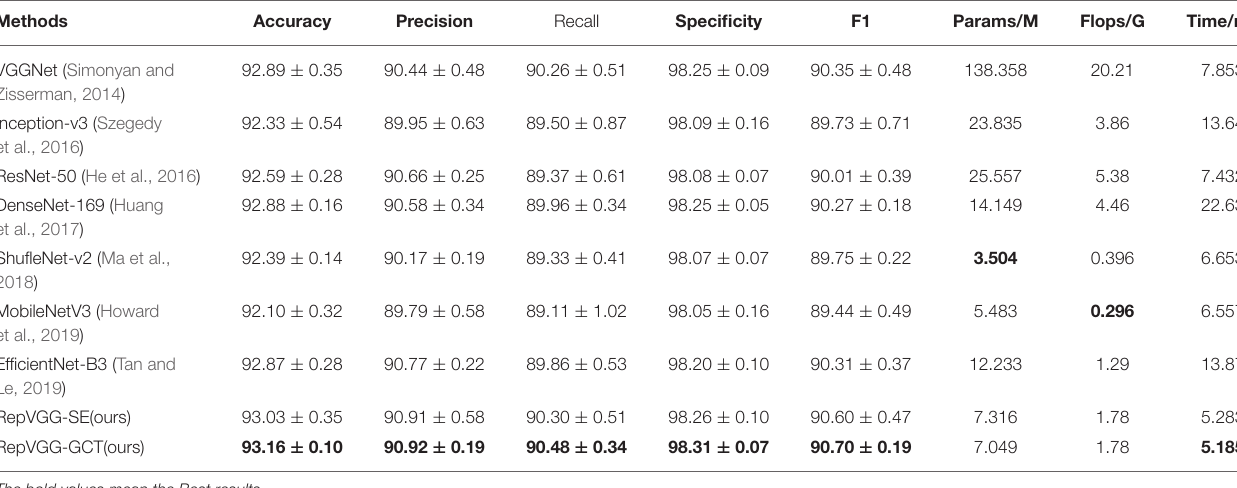
TABLE 4 | Classification performance of our RepVGG-SE model and RepVGG-GCT model and several recently published classification approaches on the TLCN datasets.